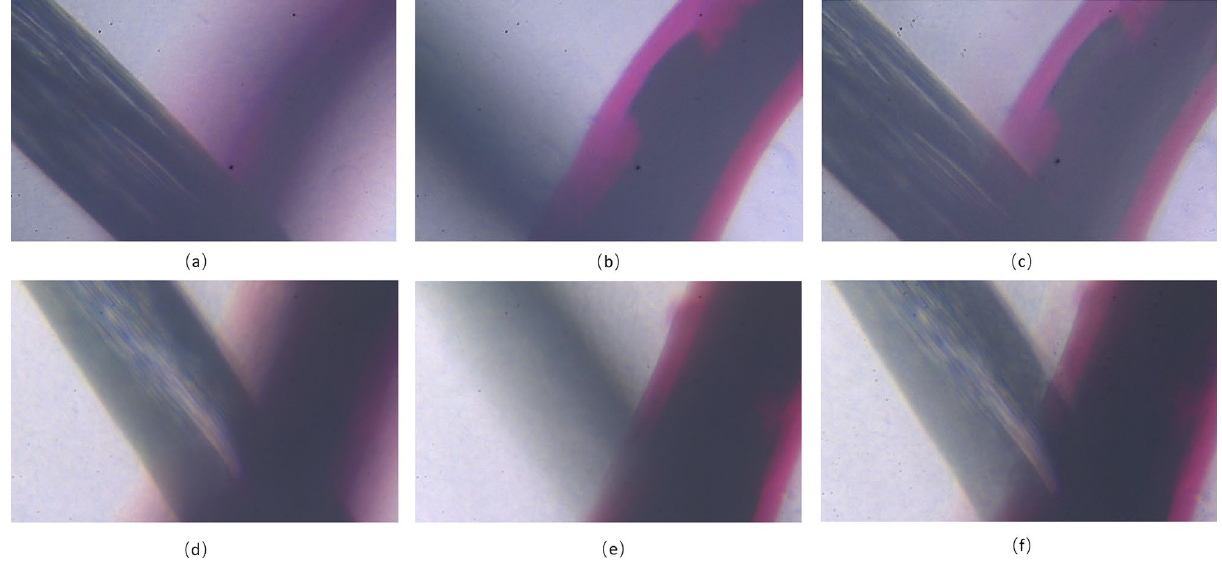
Figure 11. Experiment results of imaging whipworm slices by the proposed microscope and conventional microscope at 20×. ( a ) Image of proposed microscope at near distance. ( b ) Image of proposed microscope at far distance. ( c ) EDOF image of the proposed microscope at 20×. ( d ) Image of conventional microscope at near distance. ( e ) Image of conventional microscope at far distance. ( f ) EDOF image of conventional microscope at